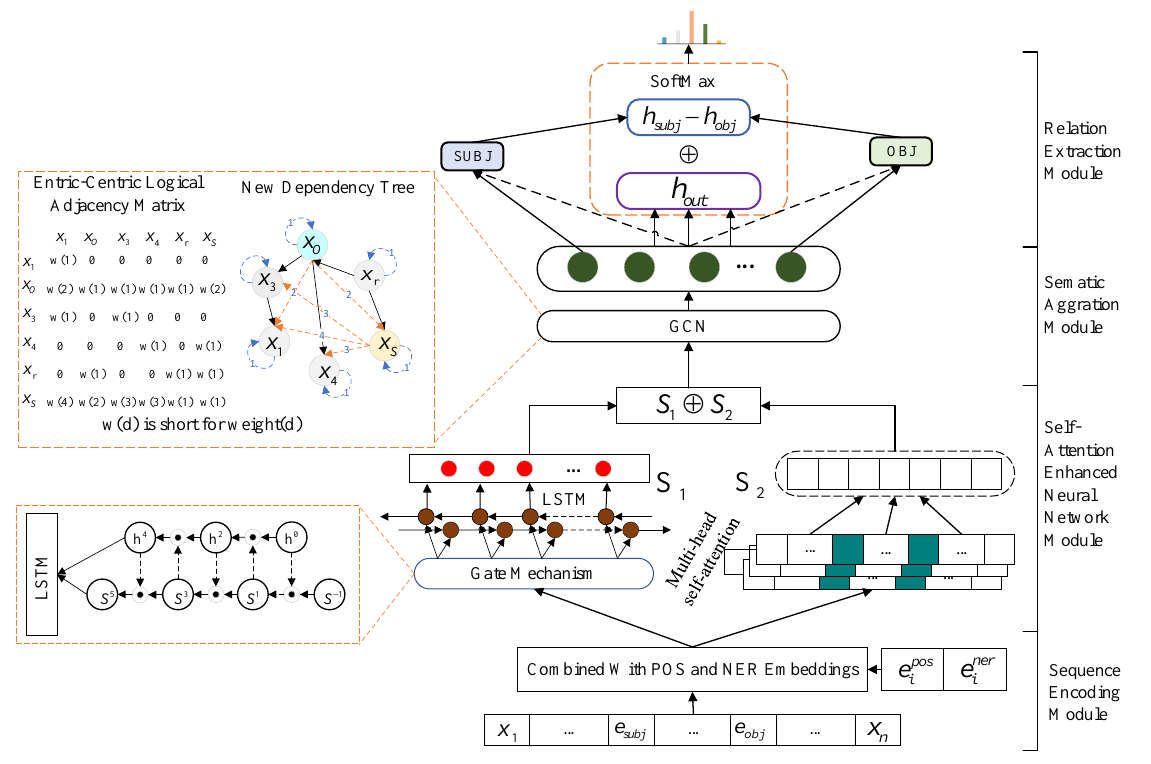
Figure 1. Model architecture diagram. The right side of the figure is the overall architecture of the model’s algorithm. The left half describes the extended LSTM with a gate mechanism and an entity-centric logical adjacency matrix (ELAM). In the gate mechanism, S i and h i represent the output of the i-th gating interaction, S − 1 represents the input sentence S, and h 0 represents an initialized hidden state. In the ELAM, the nodes of x O and x S represent the subject entity and object entity, respectively, and x r represents the root